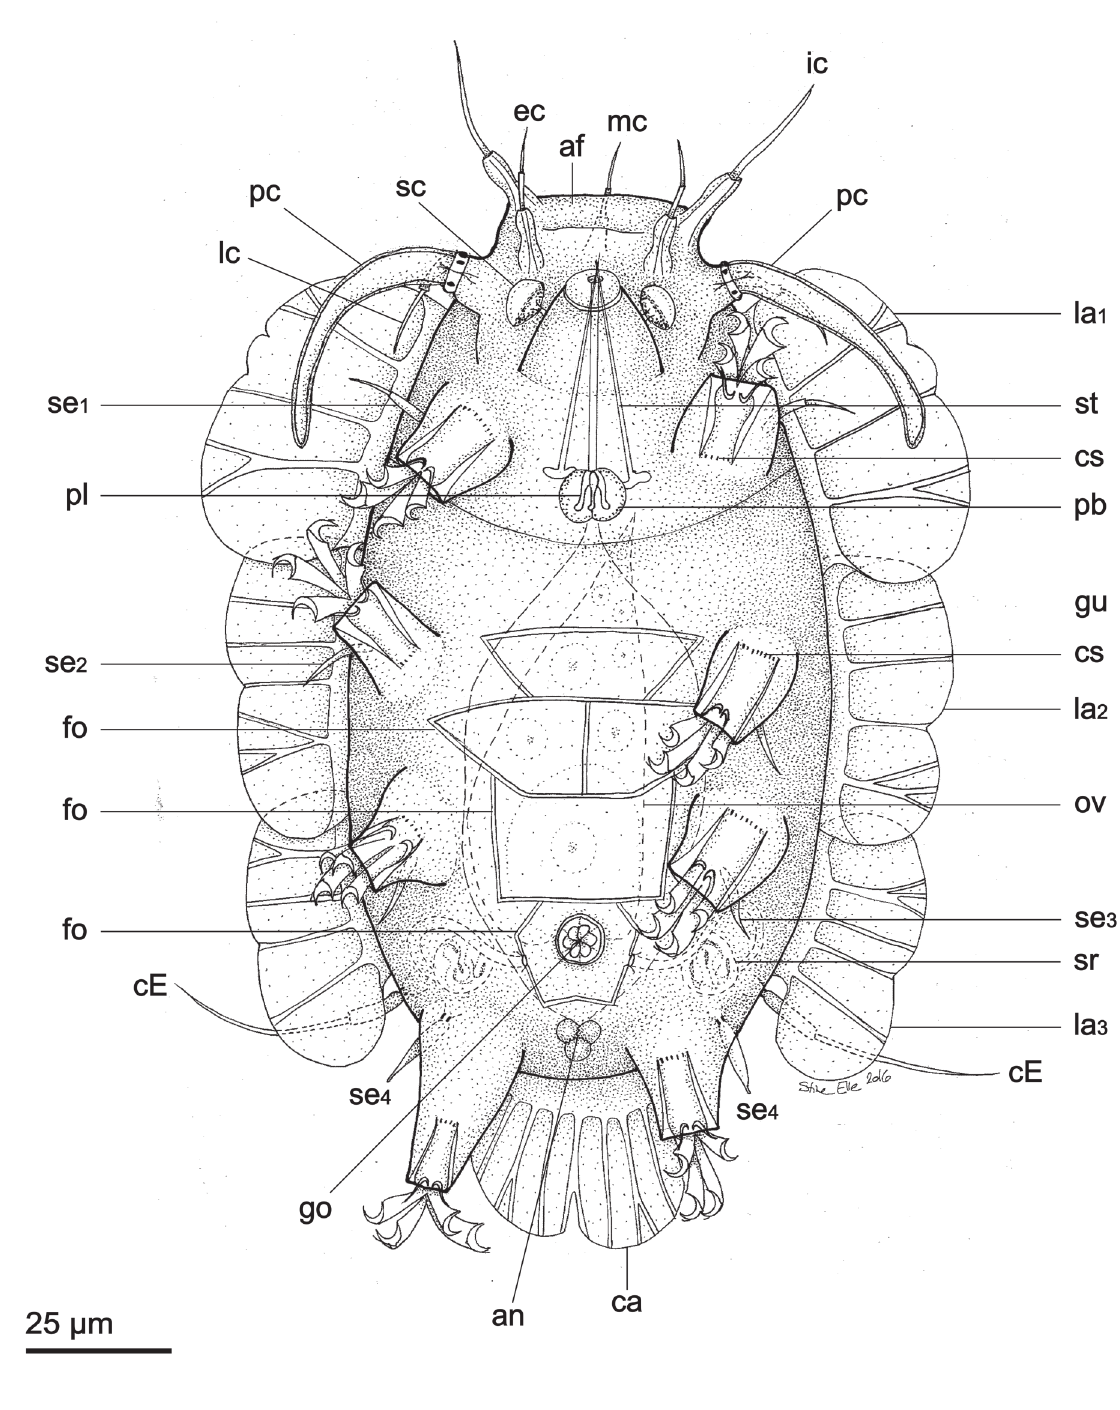
Fig. 14. Higginsarctus laurae gen. et sp. nov., holotype, ♀ (NHMD-293905). Ventral overview. Abbreviations: see Material and methods. Drawing by Stine B.